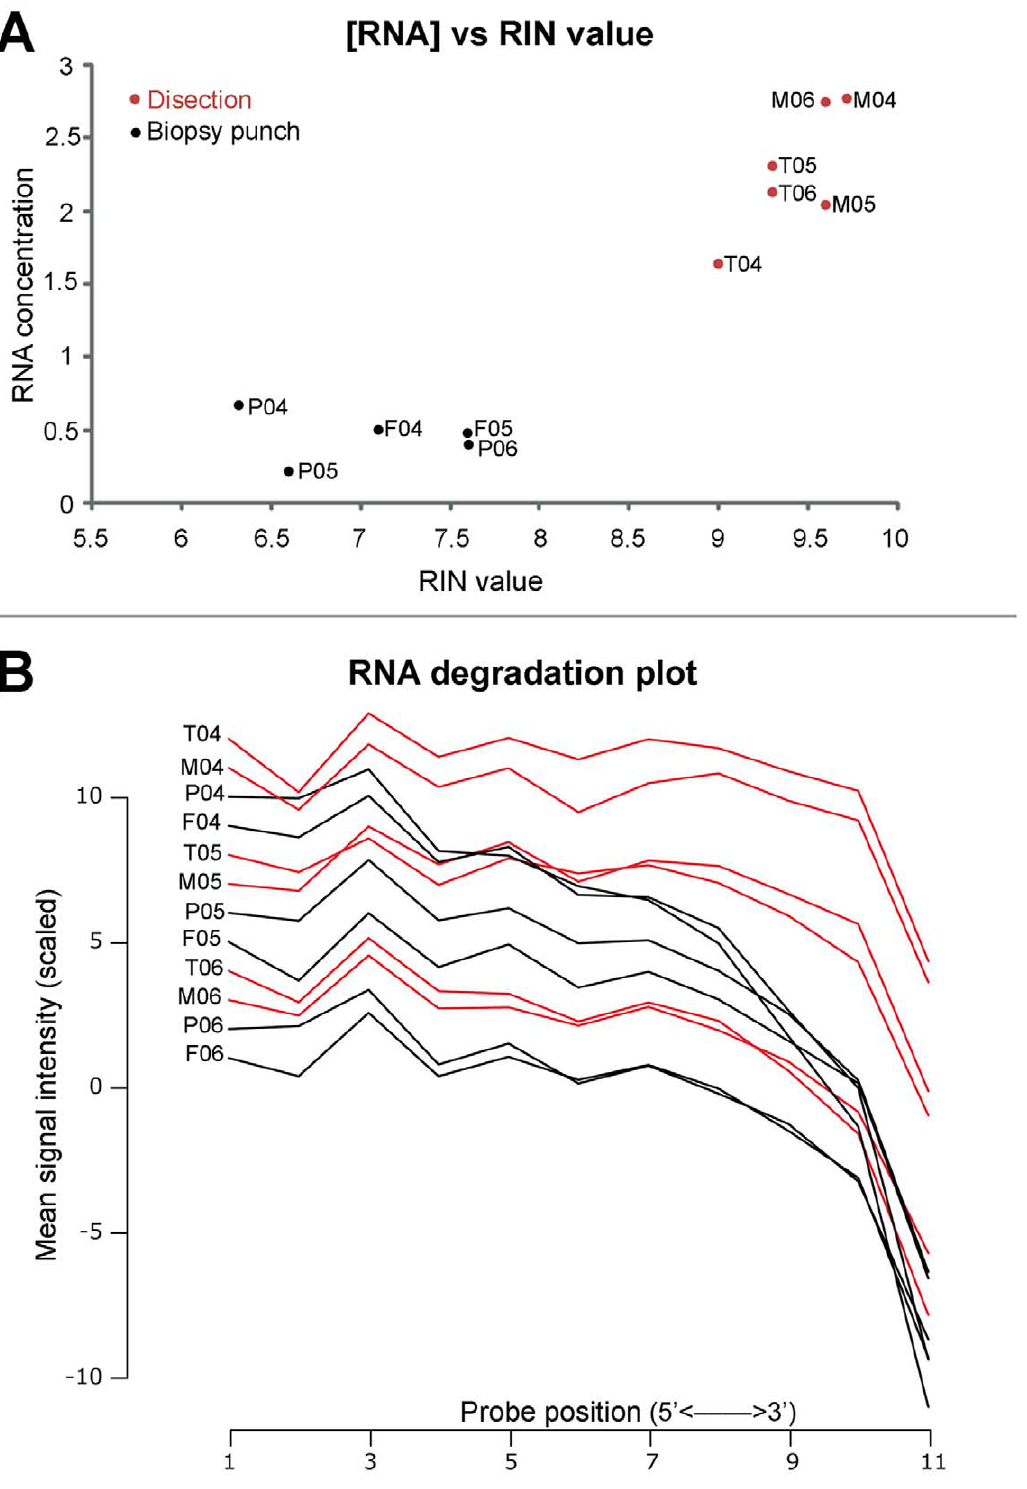
Figure 2. RNA quality measurements of the studied samples. Figure details different RNA quality measurements obtained before (A) and after microarray hybridization (B). A) Relationship between quality, measured as the RNA integrity number (RIN algorithm from Agilent), and concentration (mg/ml) of the total RNA before hybridization or PCR. Graph shows a clear separation between pedicle and frontal samples obtained using a biopsy punch and those obtained after dissection of the antler tissues. B) The degradation plot indicates the mean scales values of the different probes for all probesets in the Affymetrix arrays. As indicated in the x axis, probes are ordered according to their 5 9 to 3 9 position in the RNA sequence. RNA degradation tends to start at the 3 9 extreme and to proceed to the 5 9 extreme. The graph shows some level of degradation but does not reflect the previously observed separation between punch (black lines) and dissection obtained samples (red lines). Thus, it seems that the RNA quality differences observed prior to hybridization are not reflected by the hibridization values. Sample codes as in figure 1.